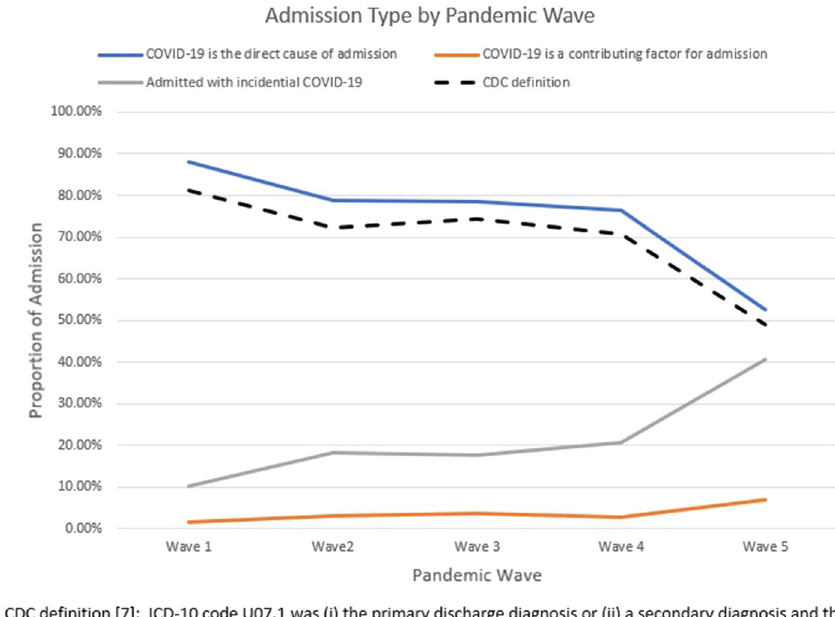
Figure 2. Admission type by pandemic wave in study